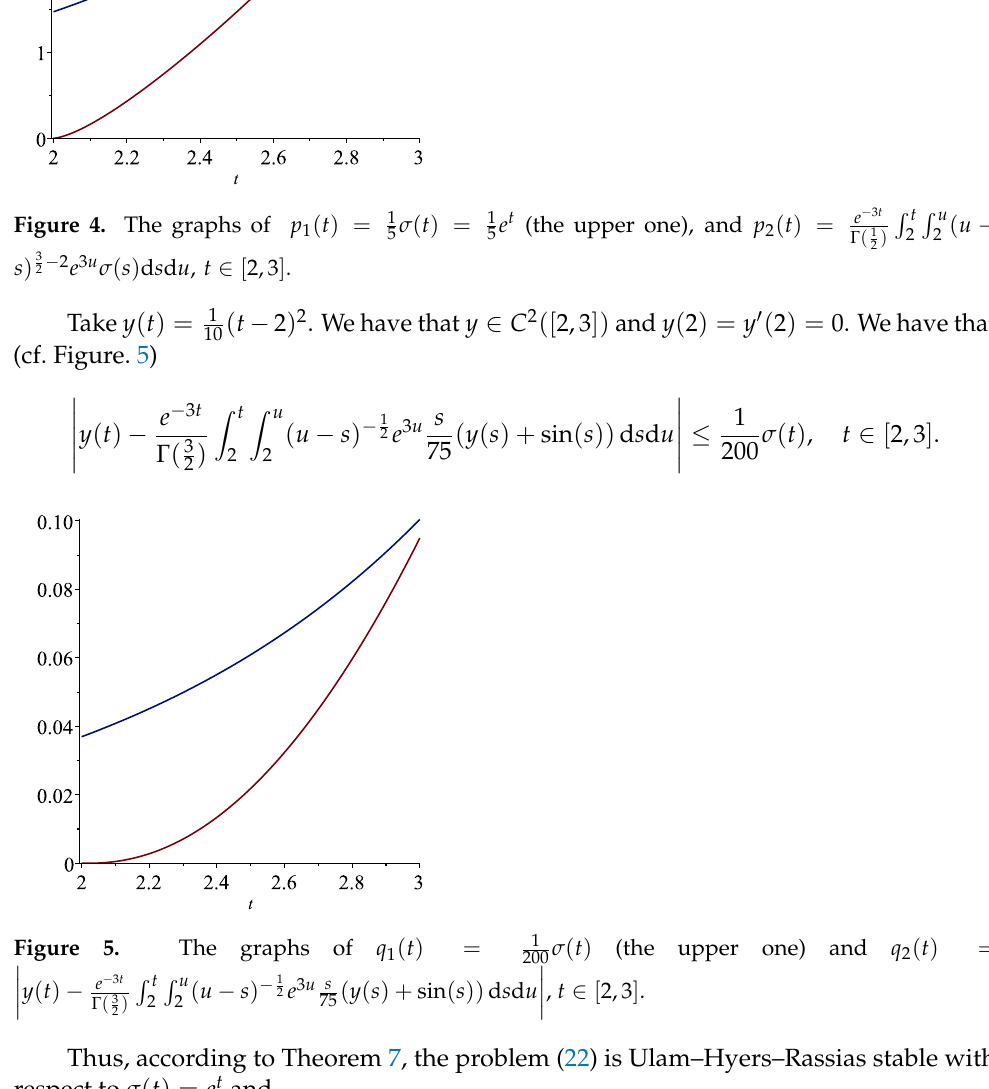
( y ( s ) + sin ( s )) d s d u 75